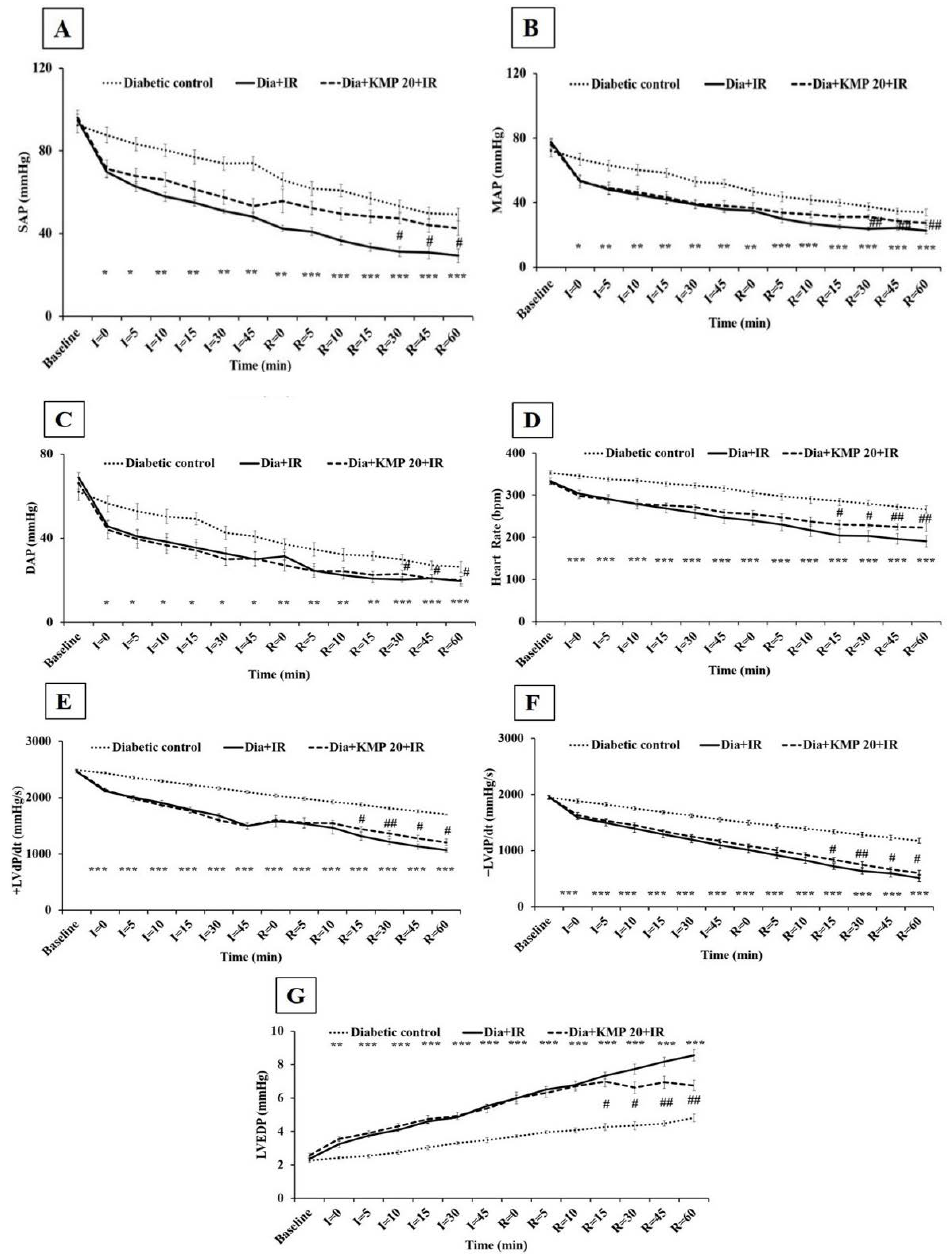
Figure 1. Effect of kaempferol on ( A ) systolic arterial pressure (SAP); ( B ) mean arterial pressure (MAP); ( C ) diastolic arterial pressure (DAP); ( D ) heart rate (HR); ( E ) maximal positive rate of the left ventricular pressure (+LVdP/dtmax); ( F ) maximal negative rate of the left ventricular pressure ( − LVdP/dtmax) and ( G ) left ventricular end diastolic pressure (LVEDP). Data are expressed as the mean ± S.E.M.; n = 6 in each group. * p < 0.05, ** p < 0.01, *** p < 0.001 vs. Diabetic control; # p < 0.05, ## p < 0.01 vs. Dia +